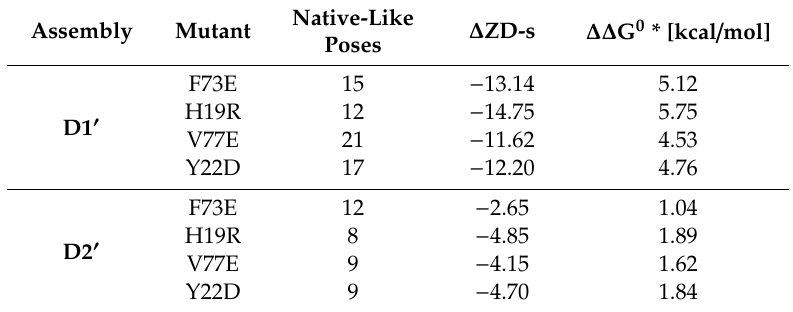
Table 3. E ff ect of the mutations on Z-dock scores and prediction of the relative free energy of binding. Native-Like ∆ ZD-s ∆∆ G 0 * [kcal / Assembly Mutant Poses